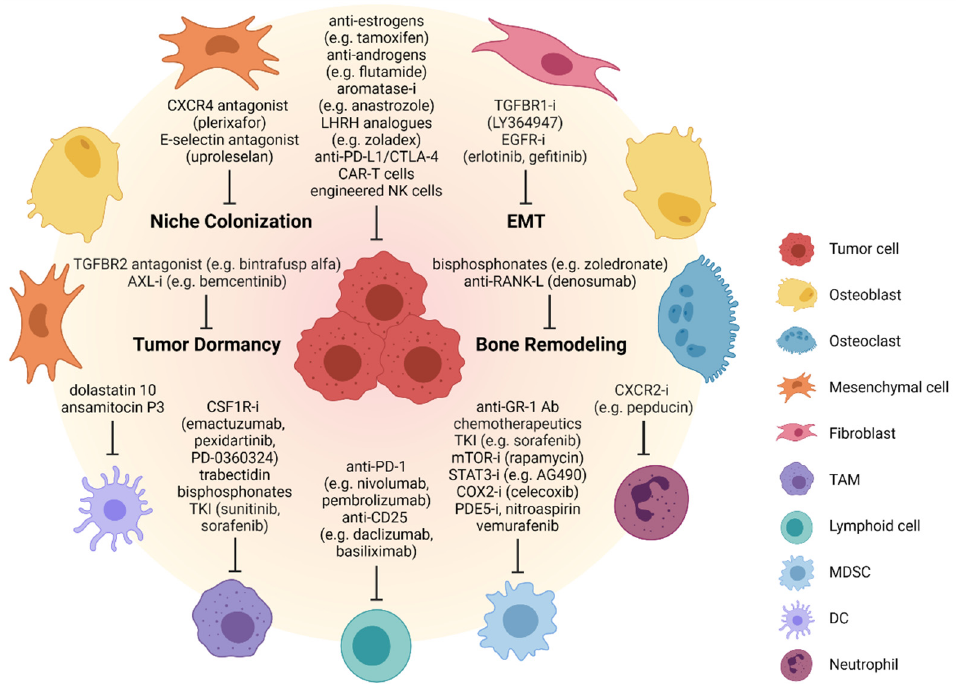
Figure 2. Bone metastasis-targeting drug candidates. Several therapeutic approaches exist to target different steps of the metastatic cascade. For example, the EMT process represents a possible therapeutic intervention point, and inhibitors against TGFBR1 and EGFR1 are currently being tested in clinical trials. Homing and colonization of the metastatic niche by disseminating cancer cells can be targeted using CXCR4 or E-selectin antagonists. Drug candidates targeting dormant tumor cells include AXL and TGFBR2 inhibitors. Bisphosphonates and the anti-RANK-L antibody denosumab can be used to inhibit osteoclast-mediated bone remodeling. Finally, several immunotherapeutic approaches to fight bone metastasis have been explored, including PD-L1 or CTLA-4 checkpoint inhibitors, CAR-T cell therapy and depletion of Tregs with anti-CD25 antibodies. Besides T cells, other immune cell types represent promising candidates for therapeutic targeting, including neutrophils, tumor-associated macrophages (TAMs), lymphoid cells, myeloid-derived suppressor cells (MDSCs) and dendritic cells (DCs). Created with BioRender.com (accessed on 27 August